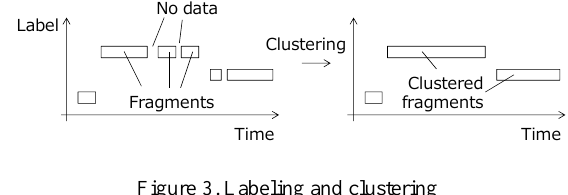
Figure 3. Labeling and clustering